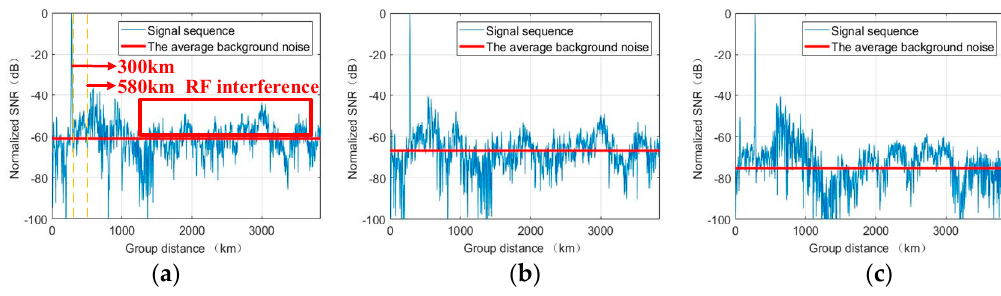
Figure 13. Normalized SNR of 6 MHz; ( a ) Channel 1; ( b ) Directly summing; ( c ) DBF.